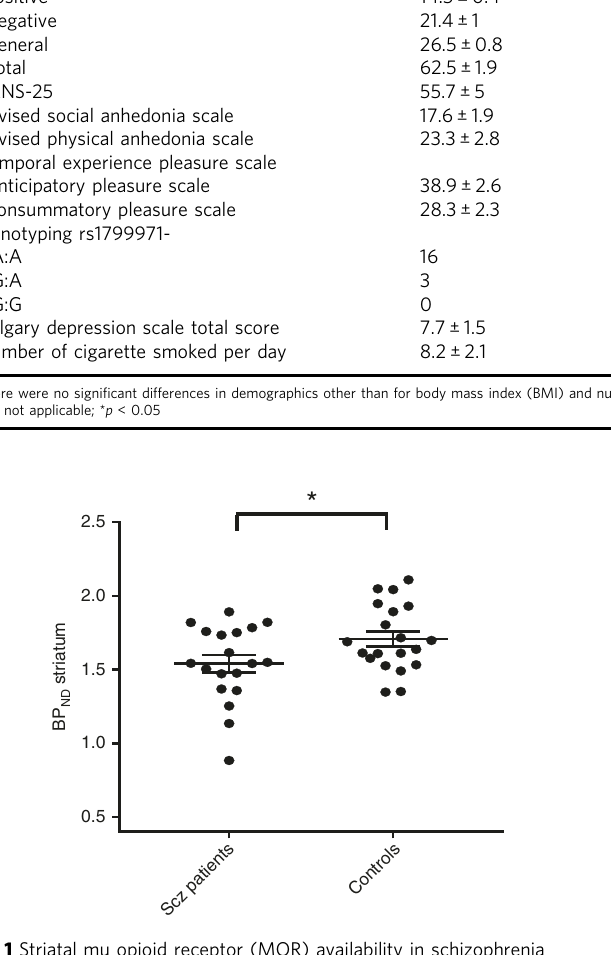
Fig. 1 Striatal mu opioid receptor (MOR) availability in schizophrenia patients and controls showing means (horizontal line) and standard error (error bars). There was a signi fi cant reduction in the MOR availability in schizophrenia patients (cohen ’ s d = 0.7; * p <